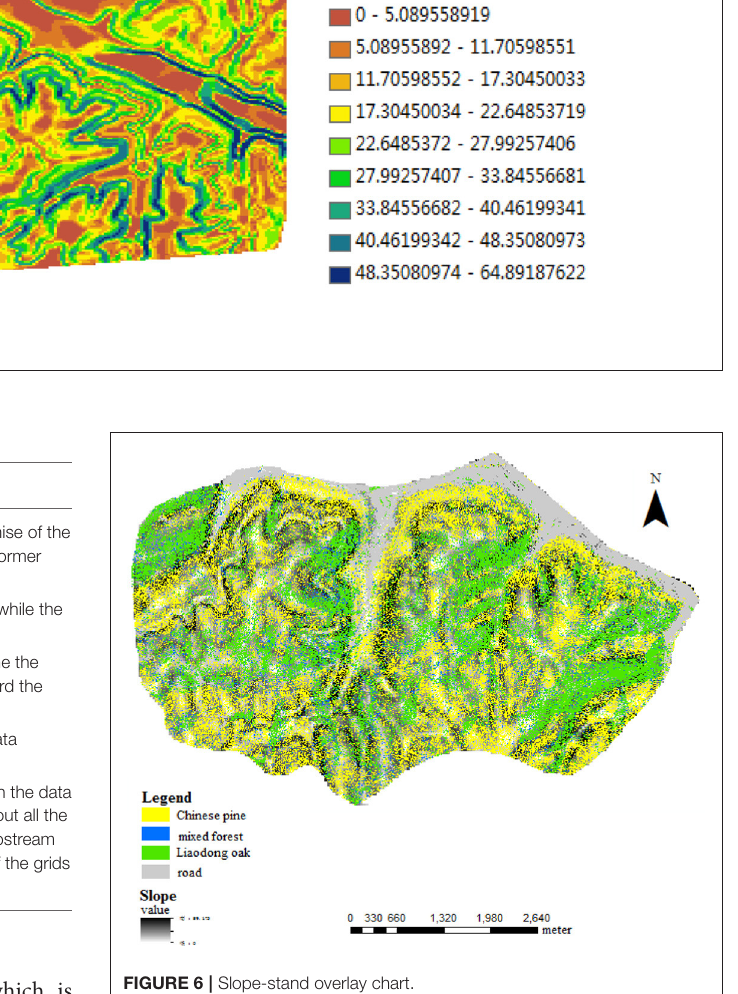
FIGURE 6 | Slope-stand overlay